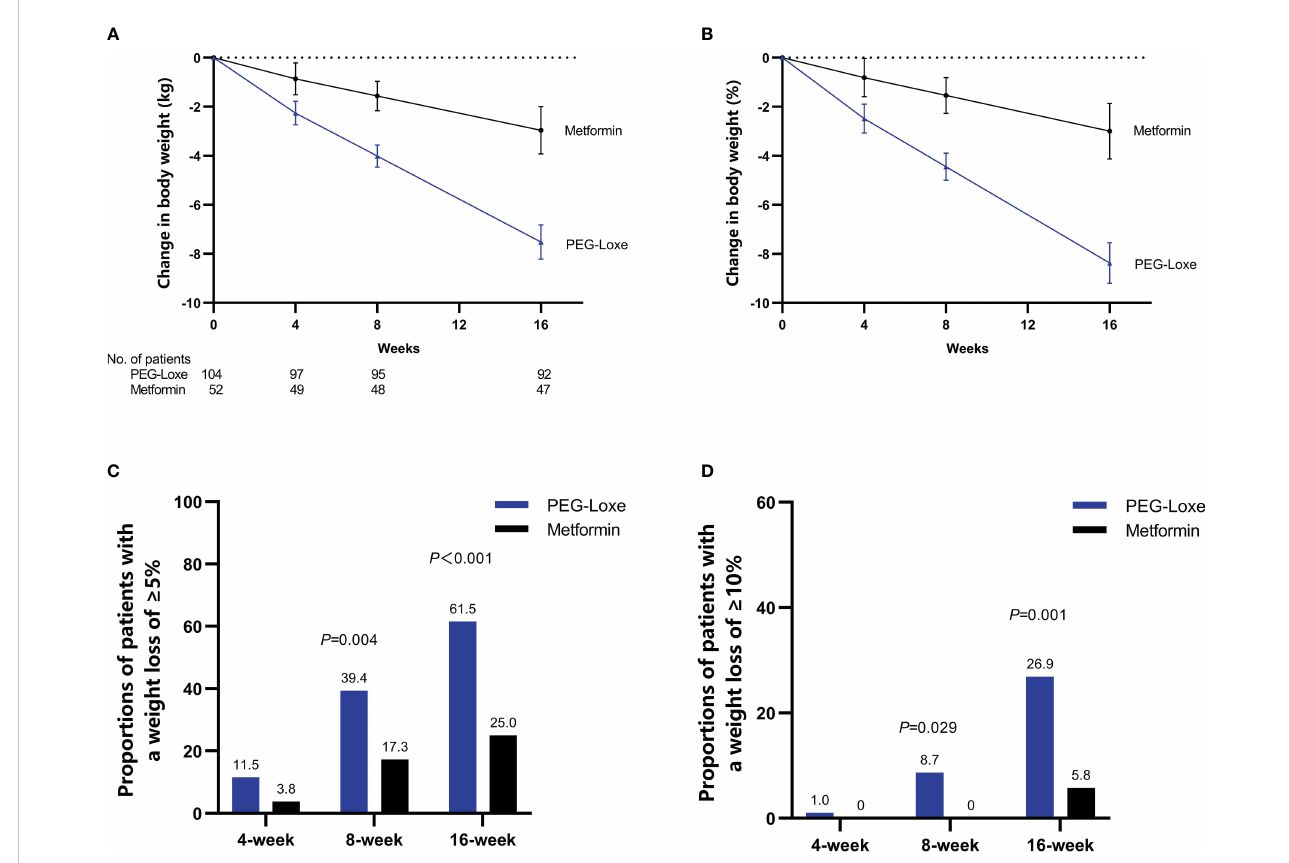
FIGURE 2 Ef fi cacy endpoints during the 16-week treatment period: time course of absolute (A) and relative (B) changes in body weight; proportion of patients achieving ≥ 5% (C) or ≥ 10% (D) weight loss. Error bars indicate 95%